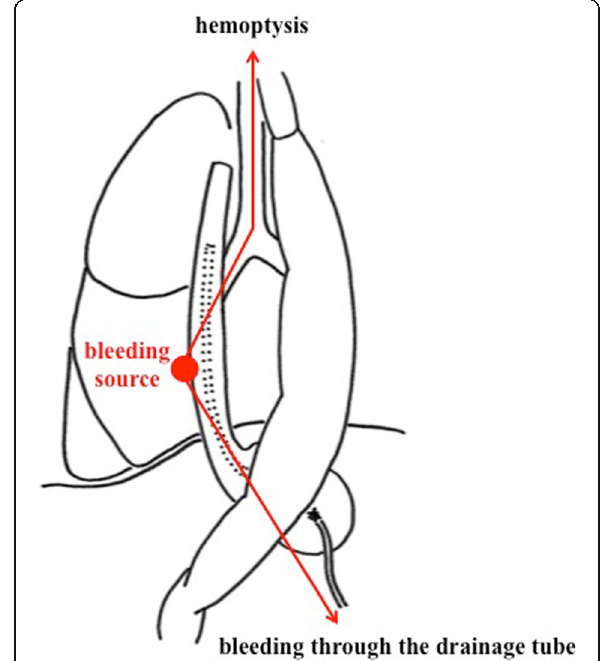
tant from the incisors and blood clots in stomach (Fig. 2).